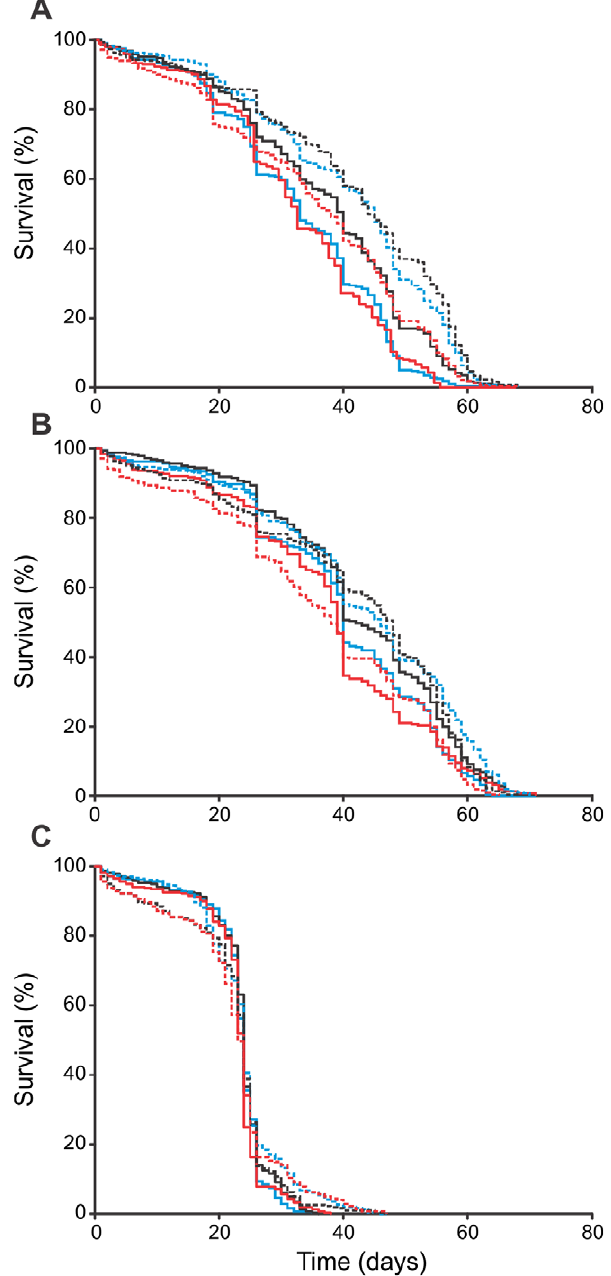
Figure 2. Mortality as measured in a reciprocal transplant assay among treatment environments at generation 35(30 hyperoxia). Mortality in male (solid) and female (dashed) D. melanogaster from populations evolved under normoxic (black), hypoxic (blue) and hyperoxic (red) treatment environments and then assayed under A) hypoxic, B) normoxic, and C) hyperoxic conditions. All populations were raised in a common normoxic environment for two generations prior to conducting the assay. Treatment means of the four replicate populations are shown for clarity. The underlying logistic mortality parameters ( a , b , s ) did not differ between treatments, nor were there any significant interactions involving treatment. Significant differences were detected as a function of sex, assay environment, and their interaction (Table 2). Longevity was measured for 320 individuals/ sex/treatment (80 individuals/sex/population) within each assay envi- ronment (see Methods).